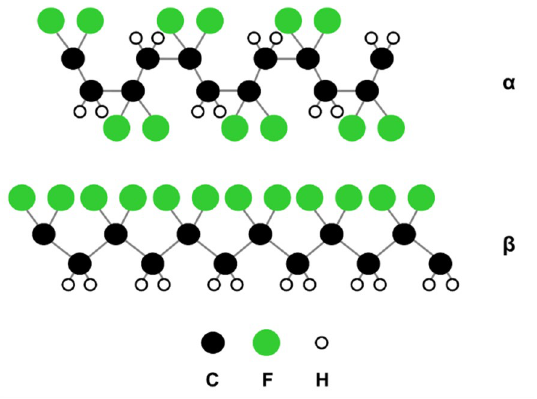
Figure 1. Schematic of PVDF α- and β-phase molecular chain